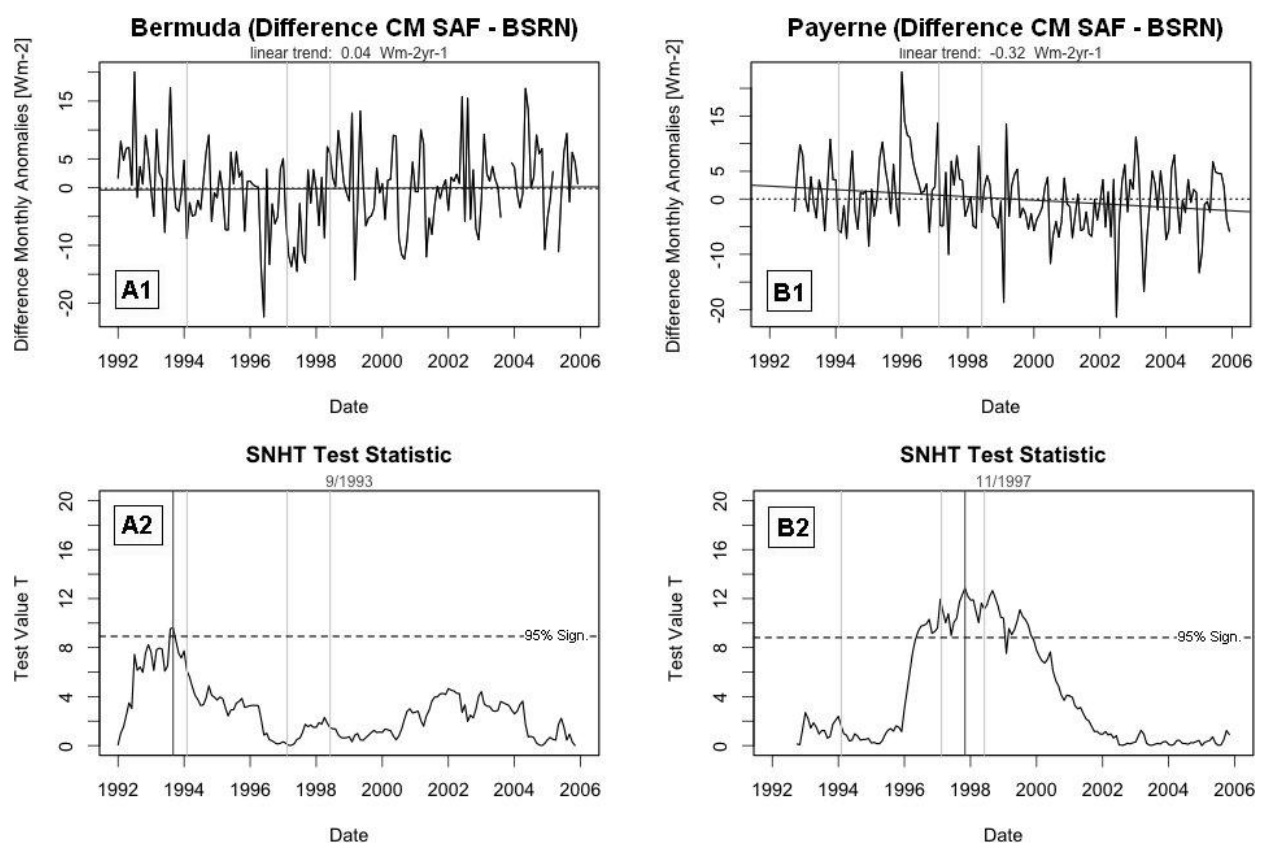
Relative SNHT analyses of the Satellite Application Facility on Climate Monitoring (CM SAF) SIS series versus BSRN station series at the sites in Bermuda ( A1, A2 ) and Payerne ( B1, B2 ). Satellite changes are indicated by vertical grey lines; detected breaks are indicated with red